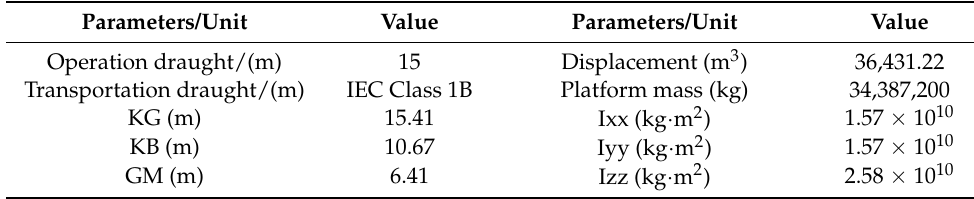
Table 2. Key design parameters of the ActiveFloat platform.